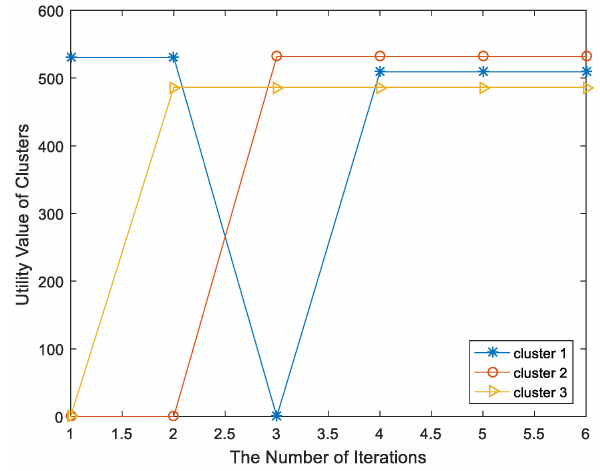
Figure 8. Utility value of cluster versus the number of iterations ( N = 32, K = 8, J = 8).